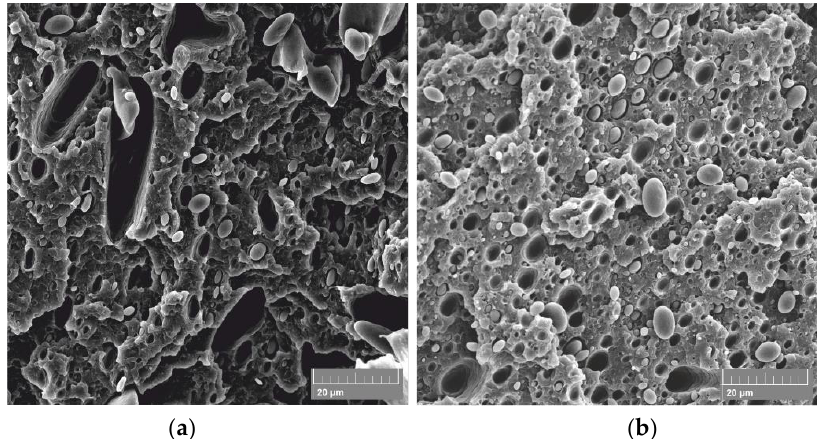
Figure 12. SEM micrographs of untreated ABS / PE-HD 90 / 10 polymer blend and treated by etching (E) and CF x coating (T); measured contact angle is indicated as CA.